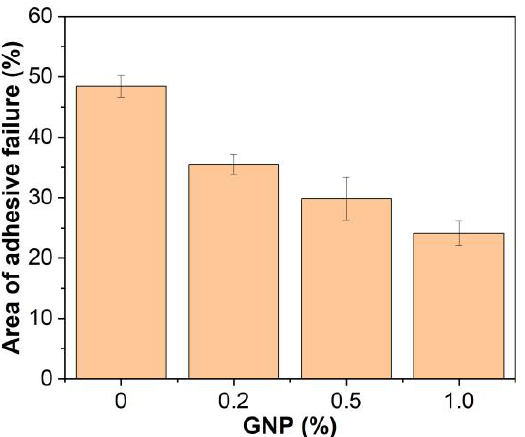
15 of 18 Figure 18. Surfaces of steel plates ( a ) and dollies ( b ) bonded by GNP-reinforced EABCs after pull- off adhesion tests at 60 °C. Figure 19 shows the areas of adhesive failure of steel plates bonded by GNP-rein- forced EABCs after room-temperature pull-off adhesion tests. Similar to single-lap shear tests, the areas of adhesive failure and cohesive failure of the neat EABC are nearly equiv- alent. When incorporating GNPs, the area of adhesive failure of the neat EABC signifi-